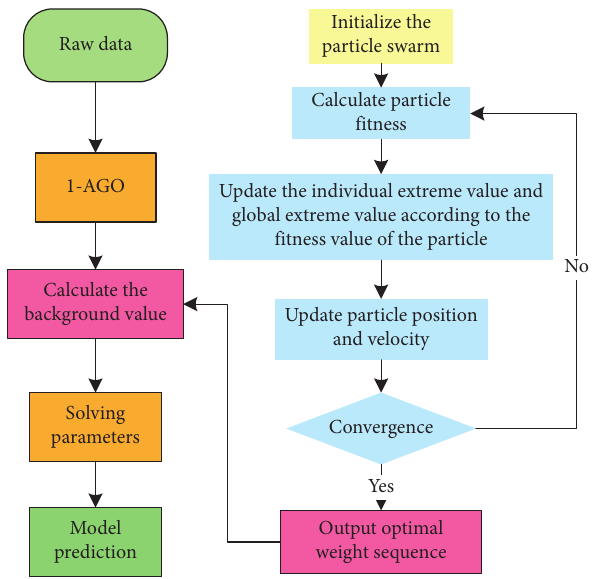
Figure 2: Flow chart of particle swarm optimization GM (1, 1)